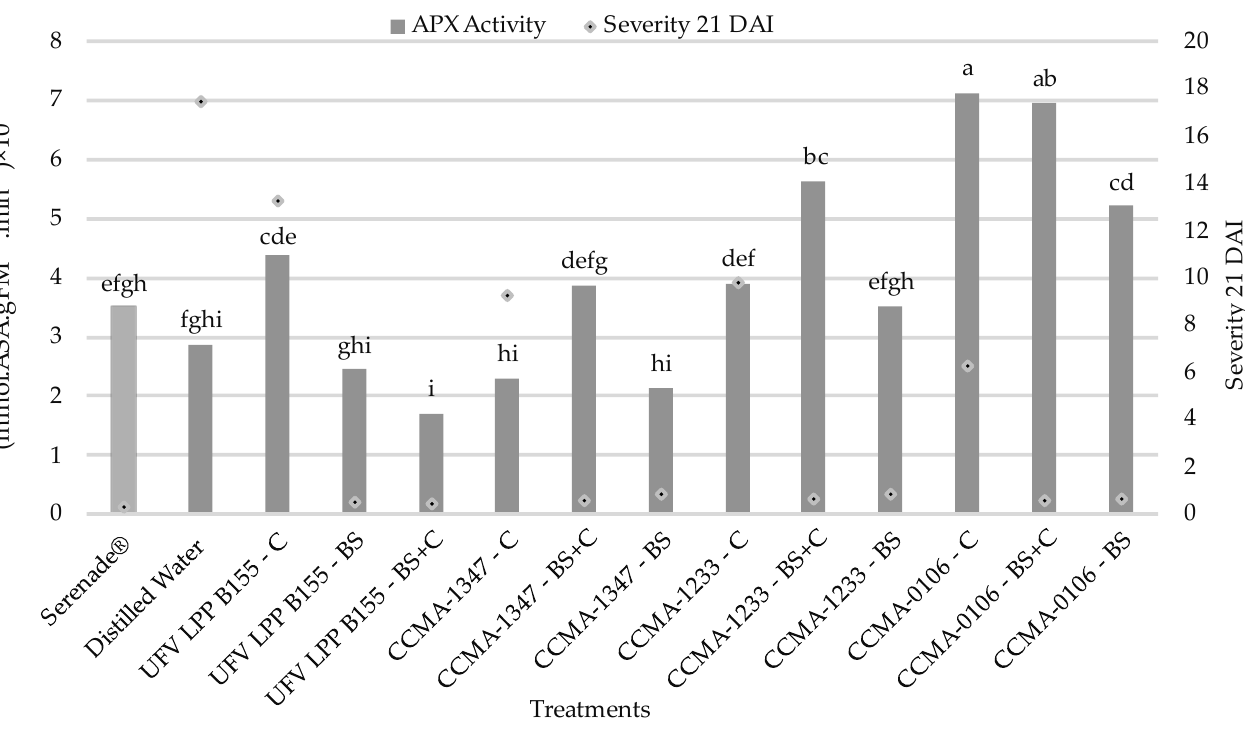
Figure 6. APX activity 21 days after pathogen inoculation. UFV LPP B155 and CCMA-1347 = B. subtilis ; CCMA-1233 = B. licheniformis ; CCMA-0106 = P. aeruginosa . BS: Biosurfactants; C: Bacterial cells; BS + C: Biosurfactants + Bacterial cells. Bars followed by the same letter do not differ from each other by Tukey’s test α = 0.05. The primary Y-axis shows activity in mmol · ASA · gFM − 1 · min − 1 , and the secondary Y-axis shows severity, represented by the dark-colored dot. Different letters reveal statistically significant variations ( p <